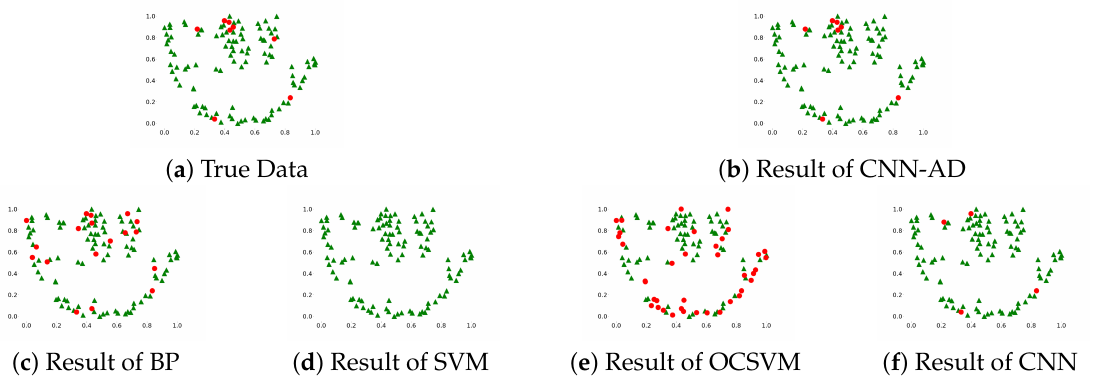
Figure 11. The prediction results of each model in the testing stage. The test data is reduced to 2 dimensions by t-sne, red indicates abnormal samples, green indicates normal